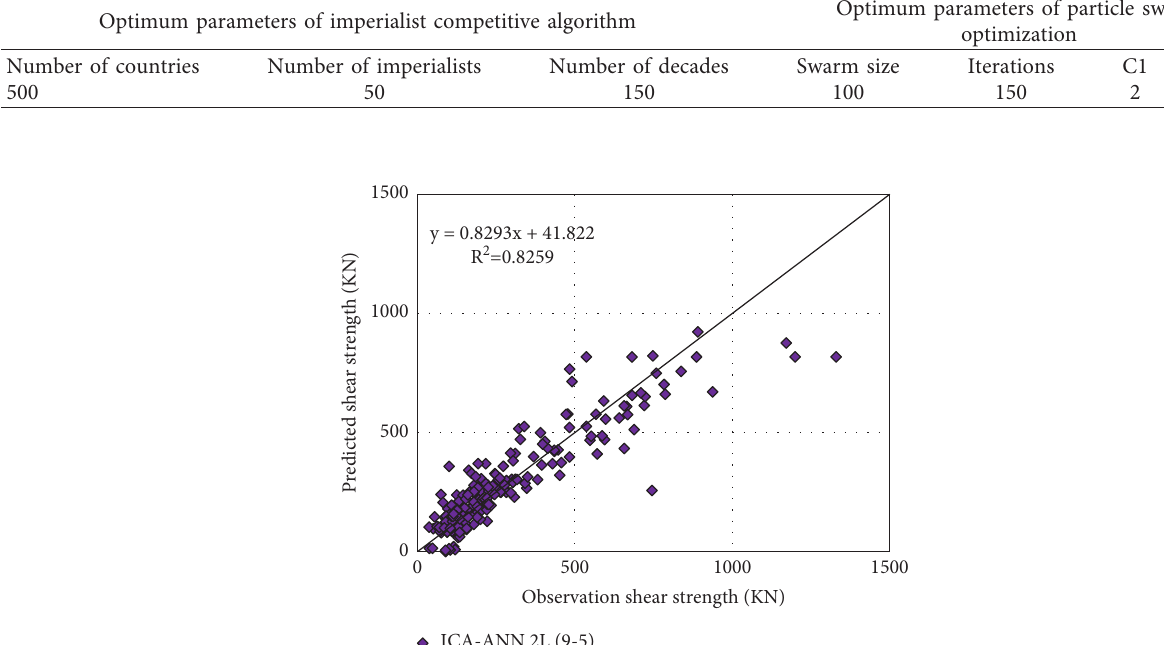
y = 0.9117x + 18.152 R 2 = 0.9002